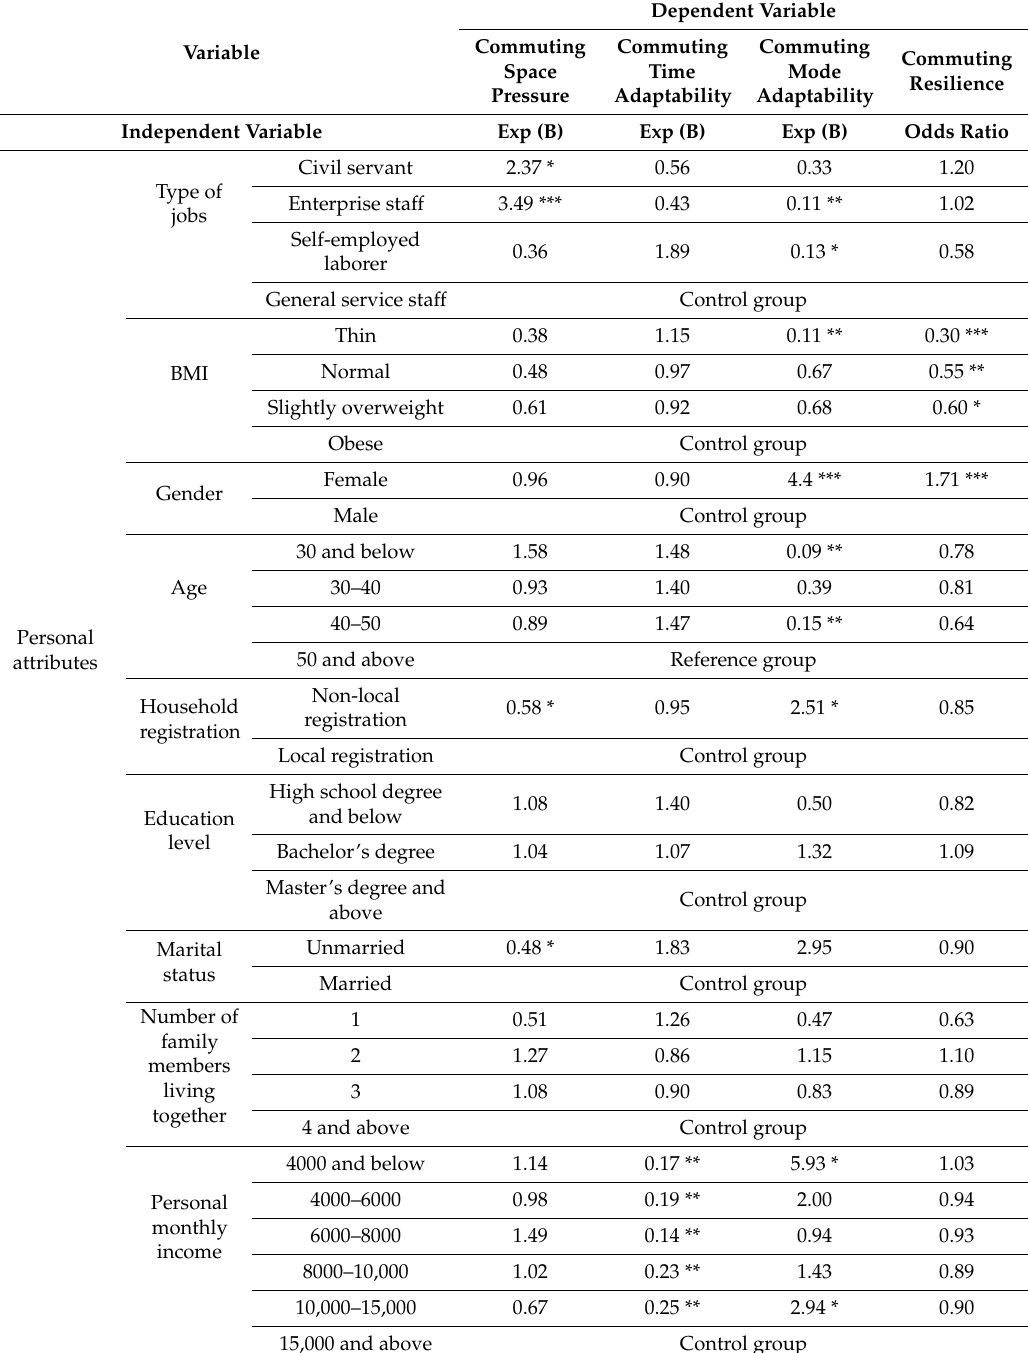
Table 6. Analysis of influencing factors of commuting behavior from the perspective of resilience